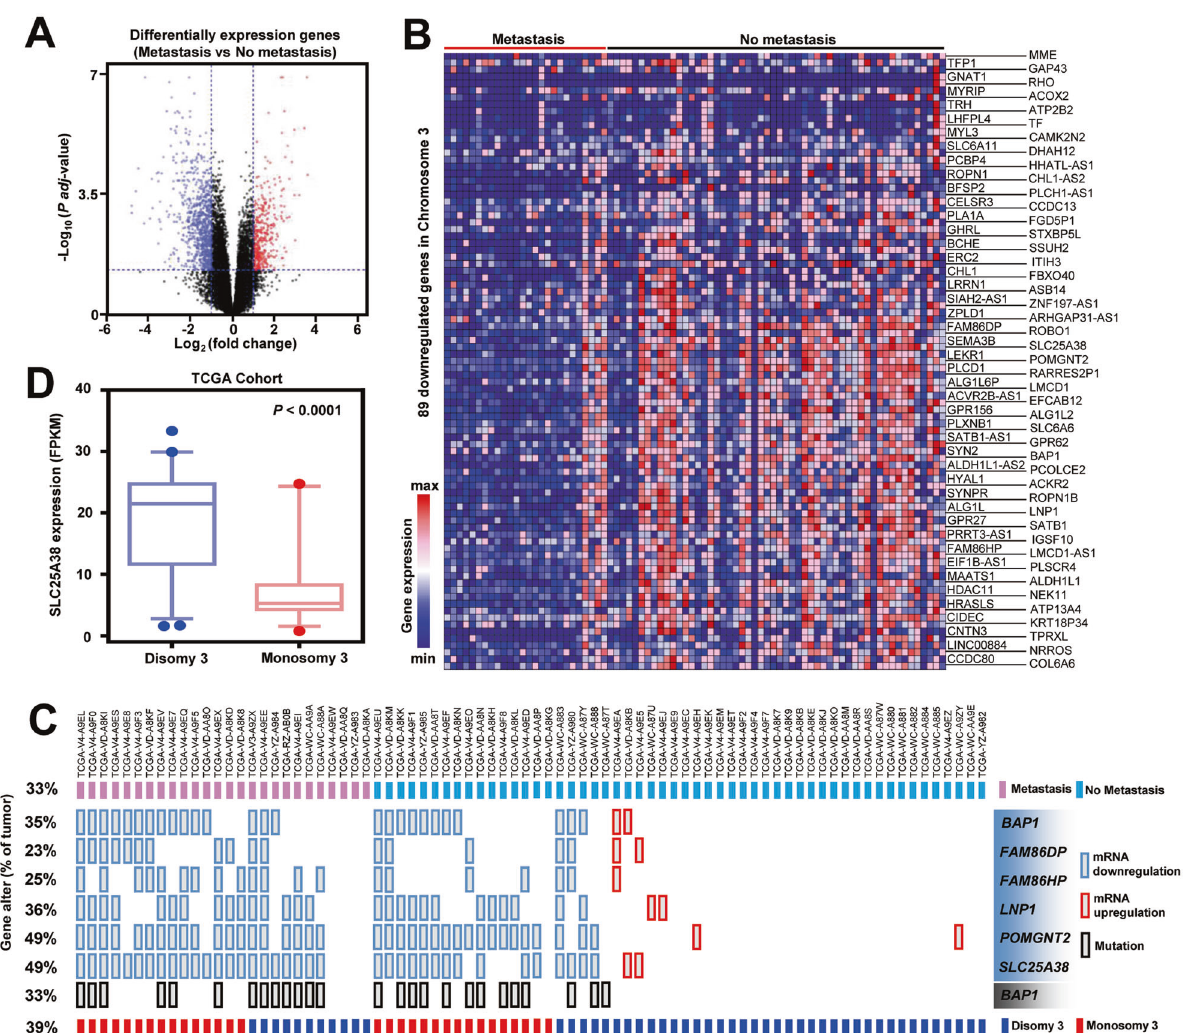
Fig. 1 Gene expression pro fi ling of primary uveal melanomas (UMs) based on metastatic status. A Volcano plots showing differentially expression genes between metastatic tumors and non-metastatic tumors in TCGA UM cohort. B Heatmap showing the 89 most highly downregulated genes located on chromosome 3. Blue: decreased gene expression, red: increased gene expression. C Molecular landscape in 80 primary UMs of TCGA cohort. Mutation or expression status for six genes, the metastatic status of tumor sample, and chromosome 3 copy number alterations are indicated. D SLC25A38 was highly expressed in tumors with disomy 3 in TCGA UM